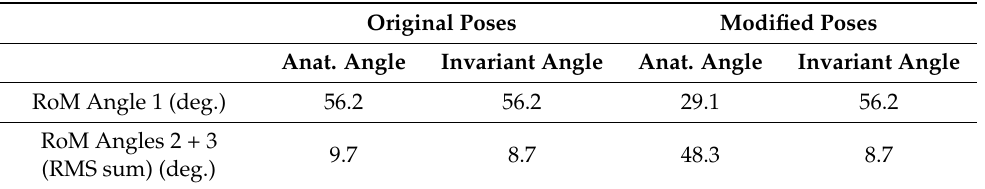
Table 1. Ranges of motion of the anatomical angles and the invariant angles in the cases of original poses and modified poses. Table 2. Root-mean-squared differences between (i) the invariant angles and anatomical angles and (ii) the invariant angles calculated based on the original measured poses and the ones calculated based on the randomly modified poses. * Values obtained up to a machine precision of 1 × 10 − 13 . RMS Difference (deg.) Inv. angles vs. anat. angles Inv. angles orig. poses vs. Inv. angles mod.